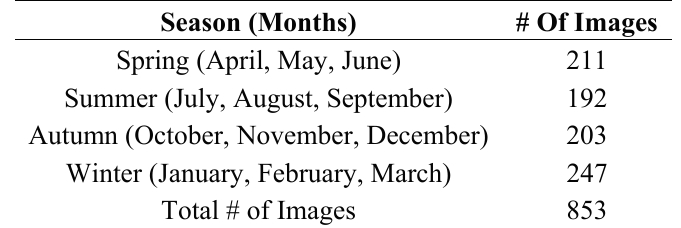
Table 1. Number of MODIS images used in each season,